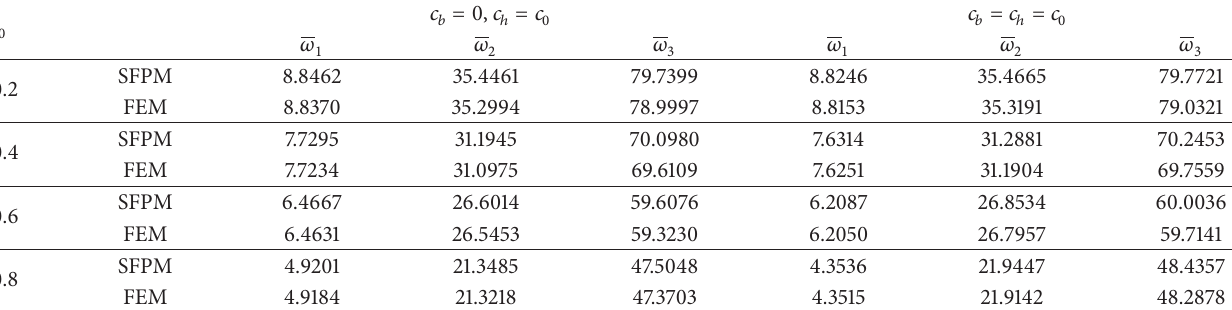
Table 5: Nondimensional transverse natural frequencies 𝜔 𝑖 for tapered homogenous beam; boundary condition: P-P. 𝑐